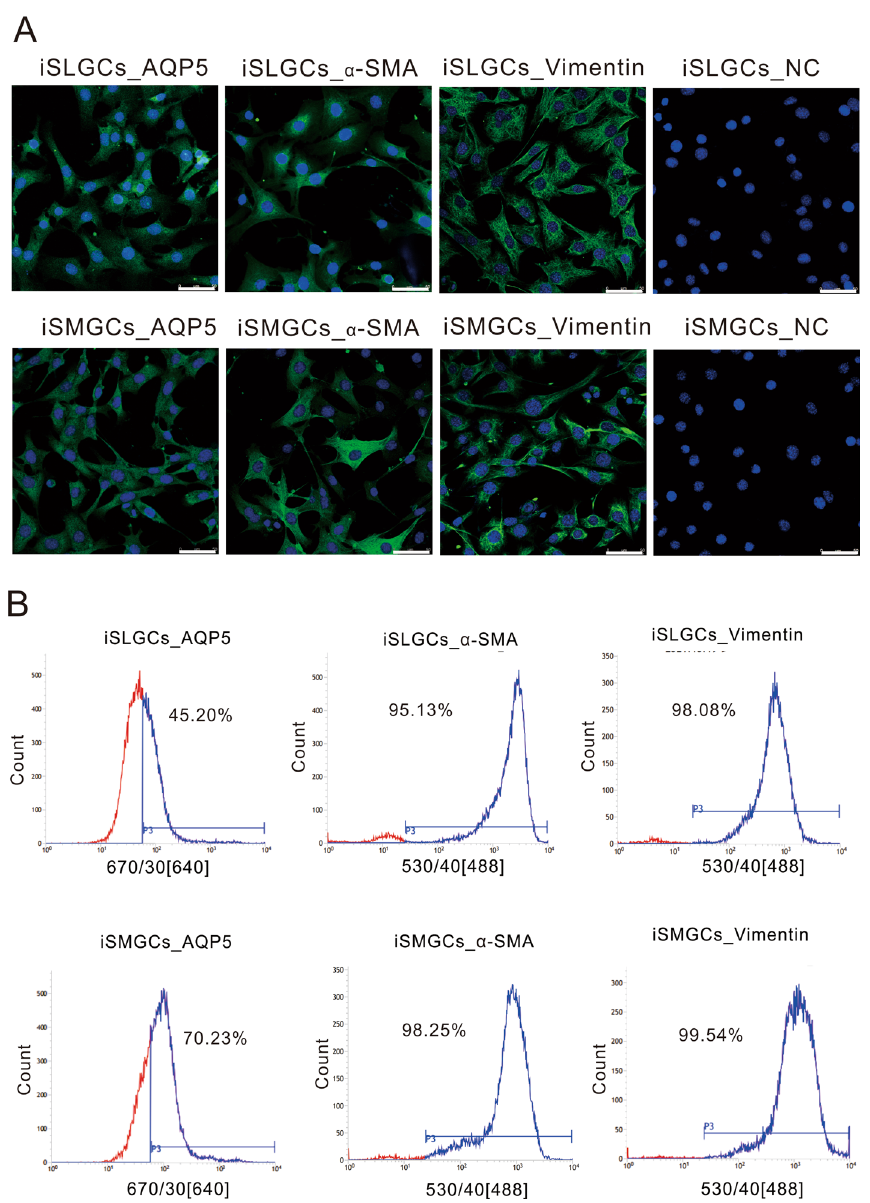
Cells were fixed with paraformaldehyde and incubated with primary and fluorescently labeled secondary antibodies in sequence. Stains without primary antibodies were used as the negative control.